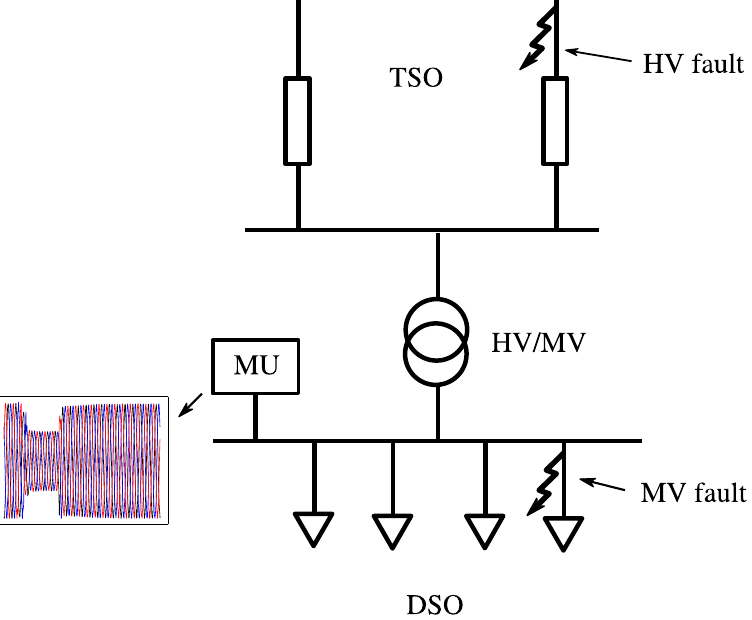
Figure 4. Voltage dip origin: upstream (top) and downstream (bottom) events.